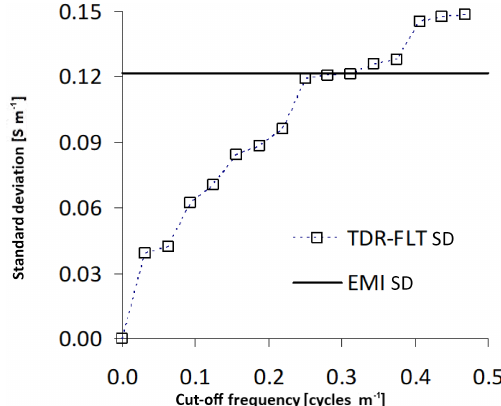
Figure 6. Standard deviation of the EMI series (horizontal black line) for the 50-6dS transect at 0.2–0.4m depth. The squares show the corresponding standard deviations for the TDR series for differ- ent levels of filtering. The intersection of the EMI line with the TDR curve allows for identifying the optimal cut-off frequency range ( ∼ 0.313cyclesm − 1 ) to make the two standard deviations